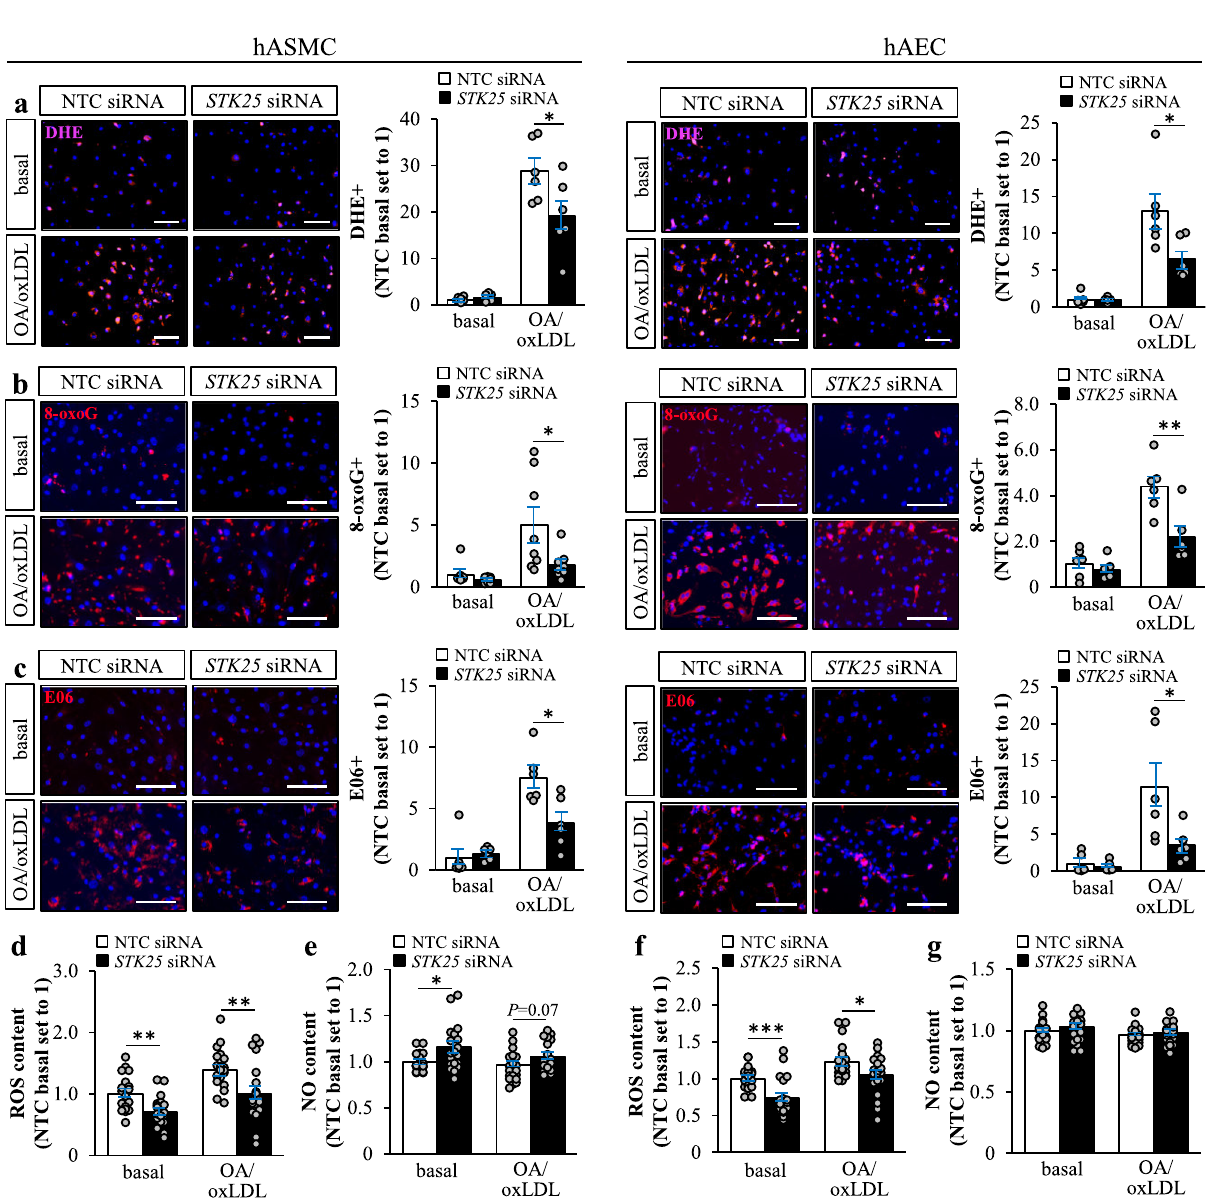
Fig. 3 STK25 regulates oxidative stress in human aortic endothelial and smooth muscle cells. hASMCs and hAECs were transfected with STK25 siRNA or NTC siRNA. a – c Representative images of cells stained with DHE (pink) or processed for immuno fl uorescence with anti-8-oxoG (red) or anti-E06 (red) antibodies; nuclei stained with DAPI (blue). Quanti fi cation of the staining. d , f Cellular ROS content. e , g Cellular NO content. In ( a – c ), the scale bars represent 100 µ m. Data in ( a – c ) are mean ± SEM from 6-8 wells per group; data in ( d – g ) are mean ± SEM from 20 wells per group. OA, oleic acid. * P < 0.05, ** P < 0.01, *** P < 0.001 for STK25 siRNA vs . NTC